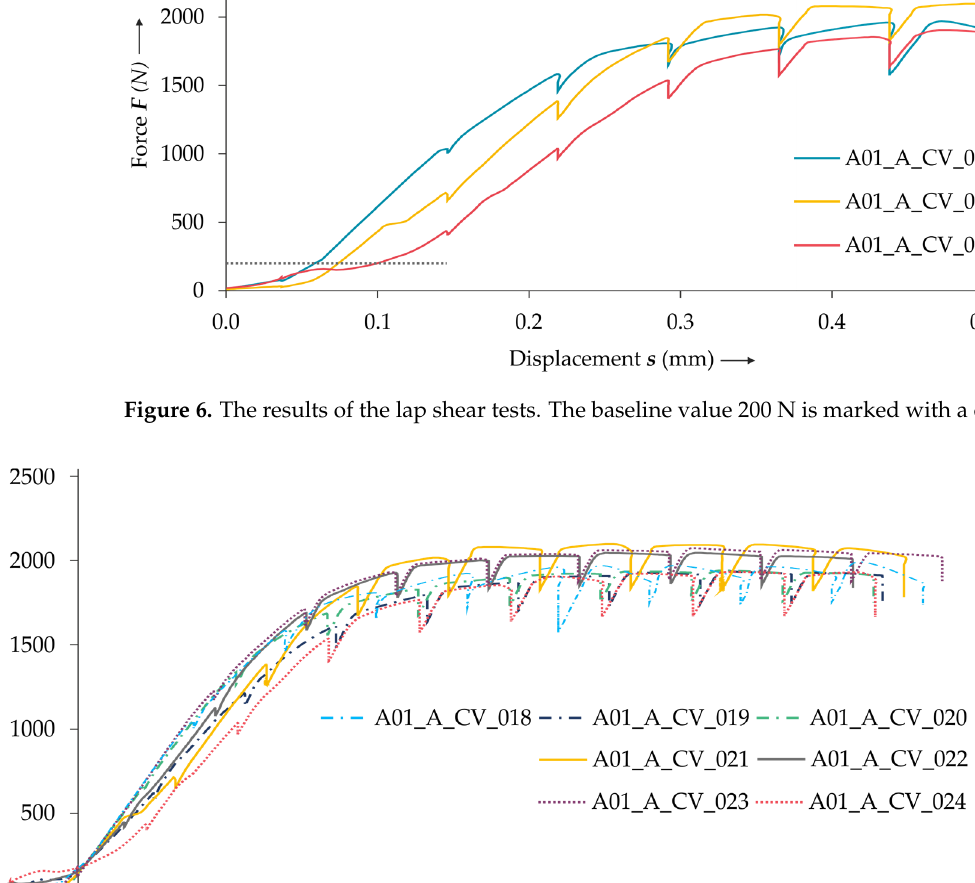
(continuous line) and without treatment (dotted line).